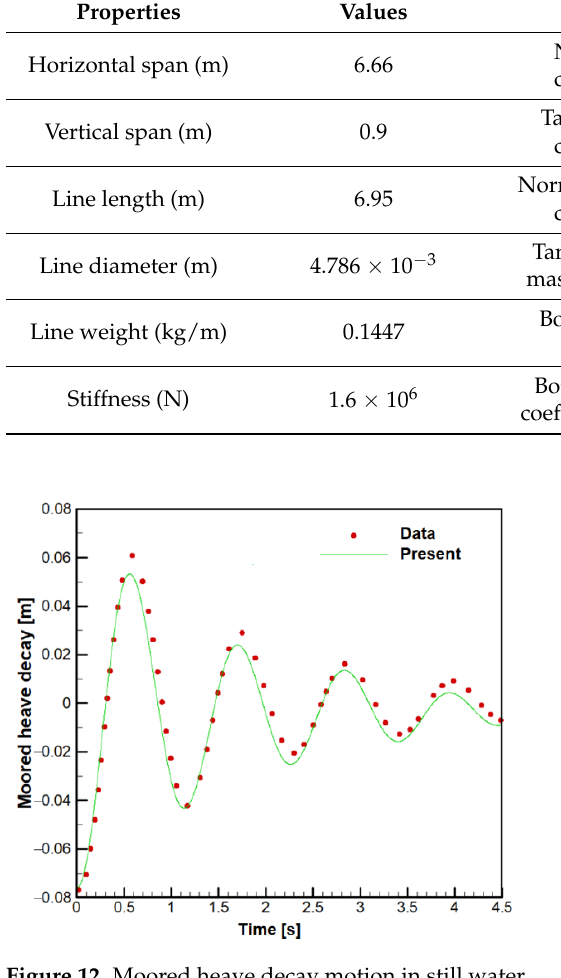
Figure 12. Moored heave decay motion in still water.